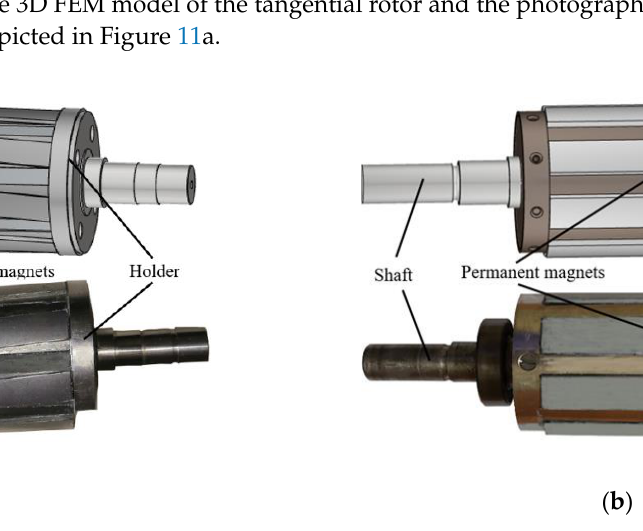
Table 3. Parameters of the computer models used to validate the results of the study .